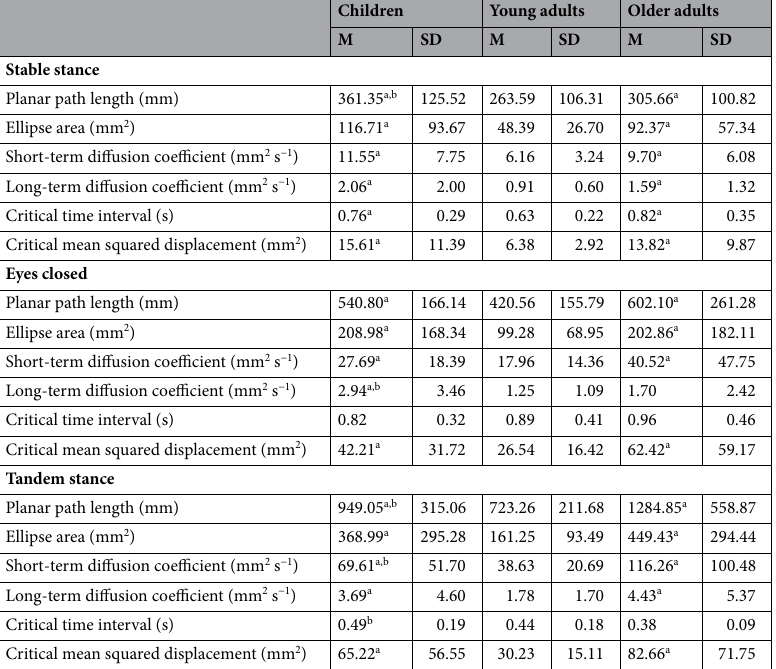
Table 1. Postural control measures for three experimental conditions and age groups. Note that these values do not depict the transformed measures used for statistical analysis. M = mean, SD = standard deviation. a denotes significant ( p < 0.05) difference when compared with young adults using unpaired t-tests. b denotes significant ( p < 0.05) difference in children when compared with older adults using unpaired t-tests. Post-hoc analyses are Bonferroni